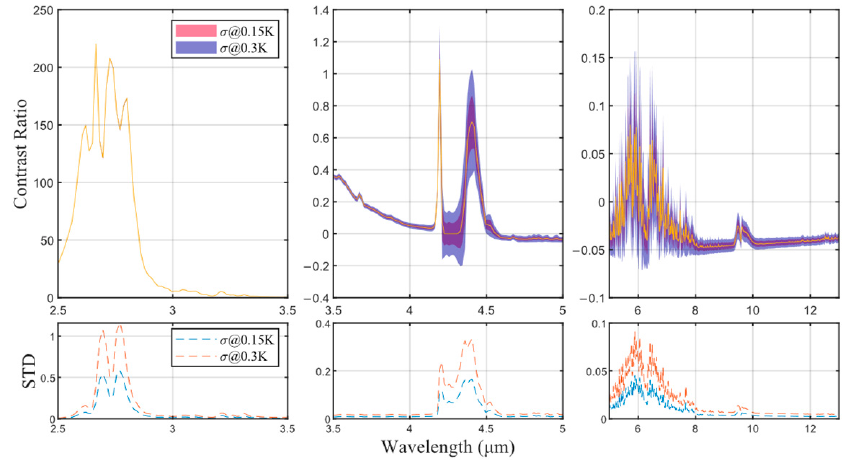
Figure 16. The variation range of target background contrast and its standard deviation curve, con- sidering the influence of noise.